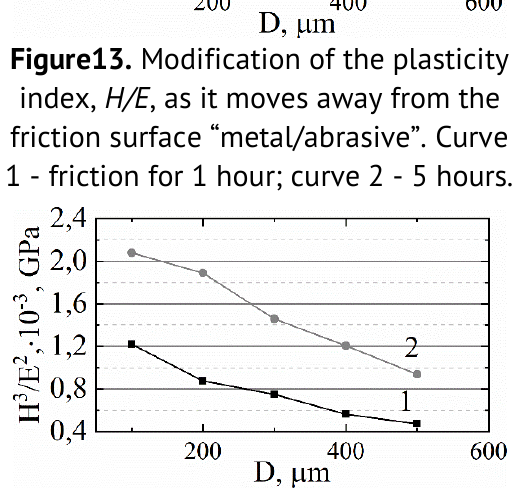
Figure 15. Modification of the resistance index, H 3 /E 2 , as it moves away from the friction surface “metal/abrasive”. Curve 1 - friction for 1 hour; curve 2 - 5